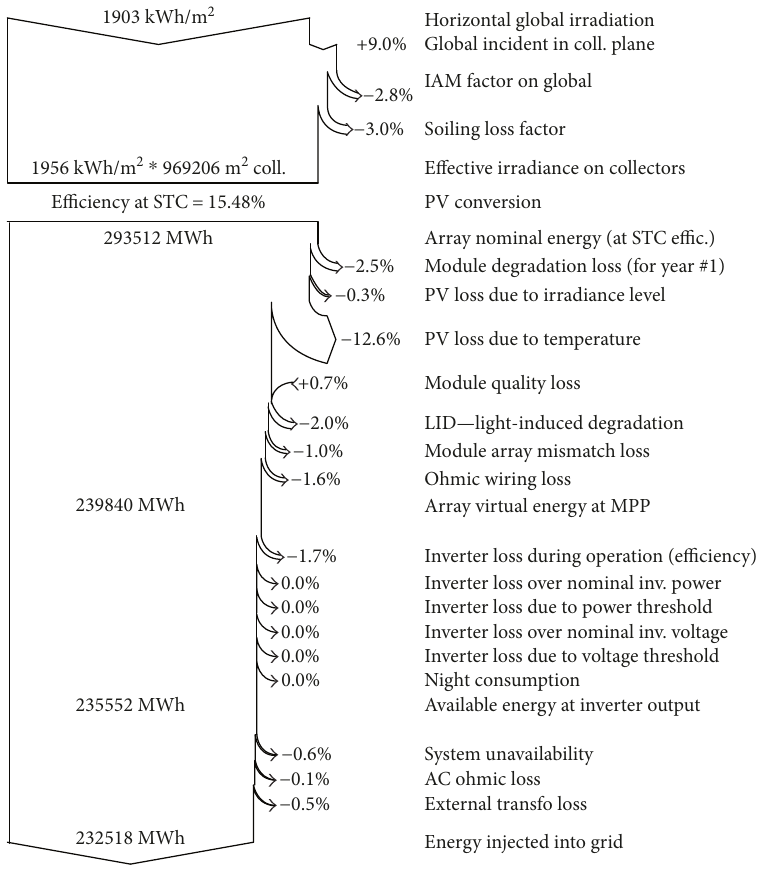
Figure 9: Simulation results of losses of the system annually.